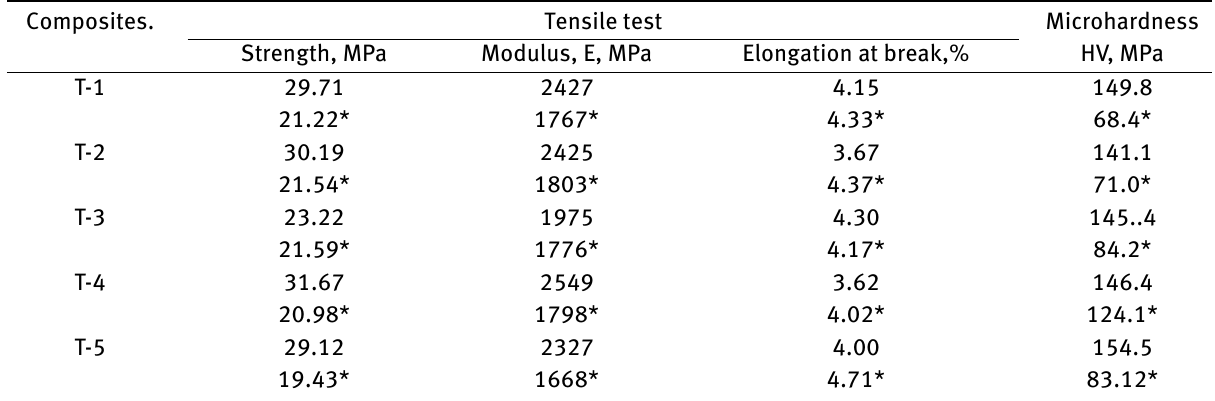
Table 2: The results of tensile tests and microhardness measurements of non-weathered and weathered* composites Composites.